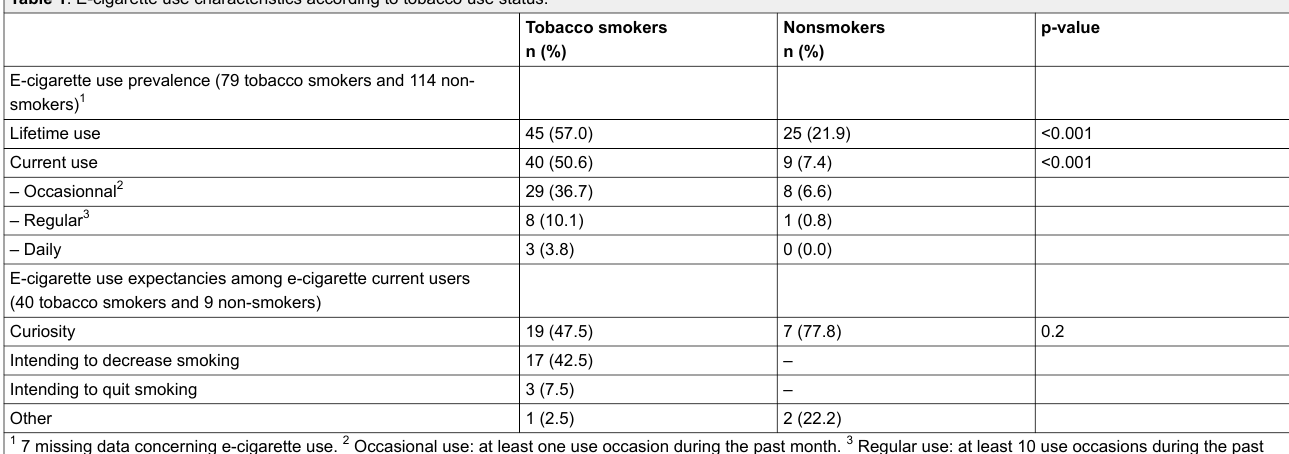
Table 1 : E-cigarette use characteristics according to tobacco use status.